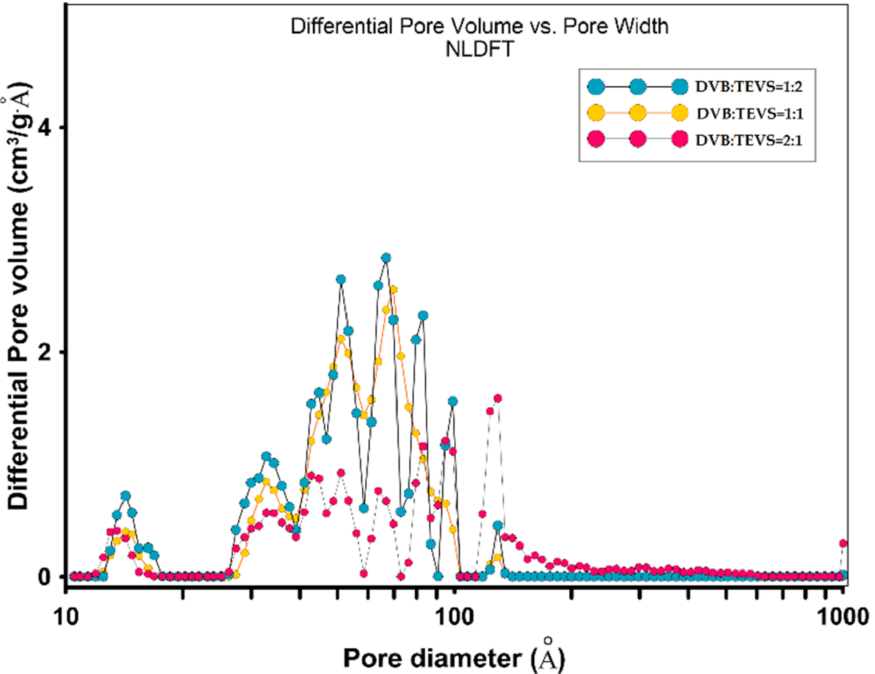
Figure 6. Pore size distributions obtained by Density Functional Theory with Model: N2 @ 77 K, Slit Pores. Method: Non-negative Regularization: 0.01000 and Standard Deviation of Fit: 6.62419 cm 3 /g